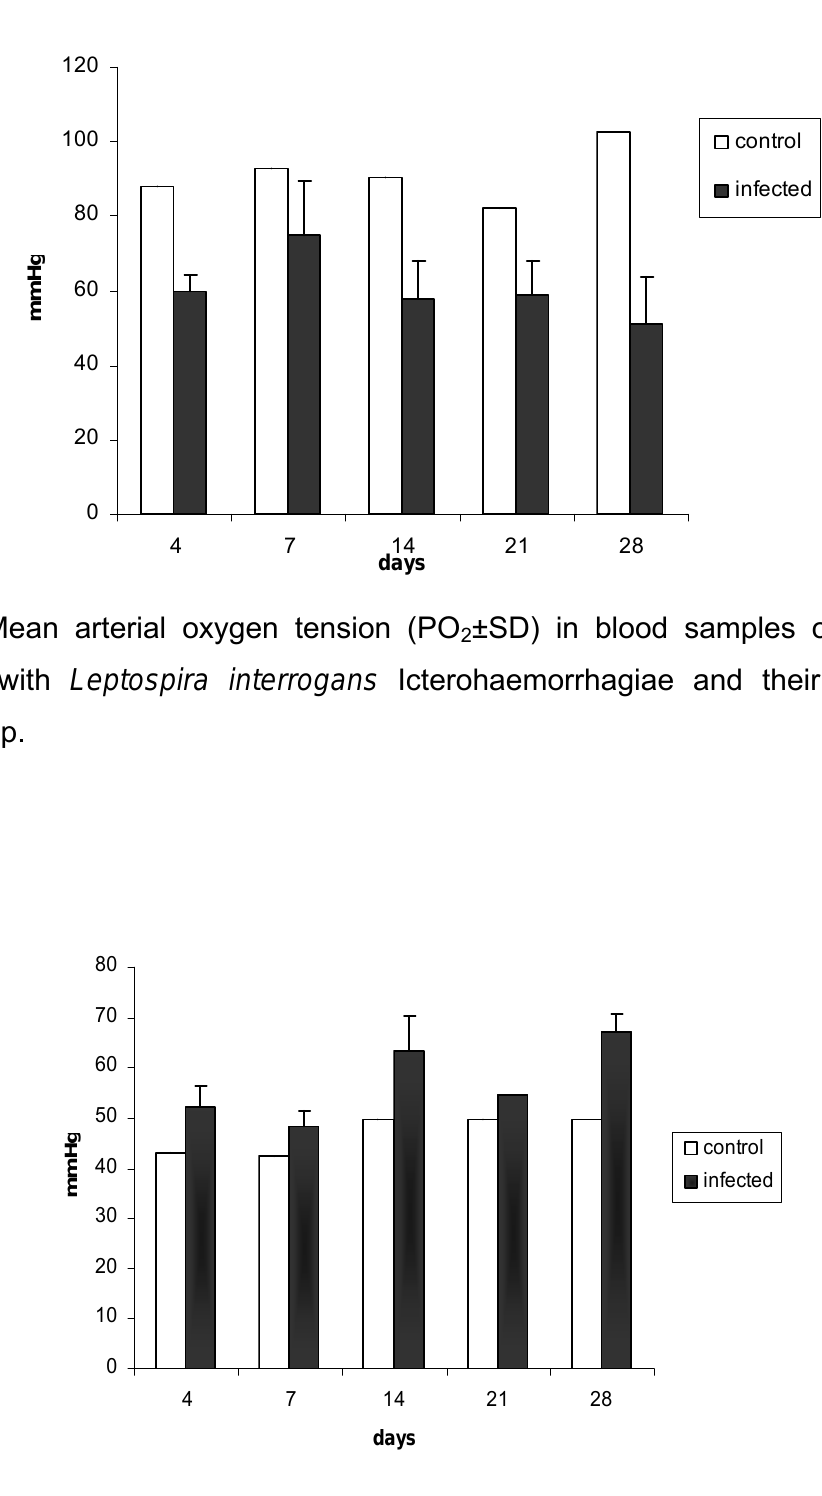
±SD) in blood samples of 2